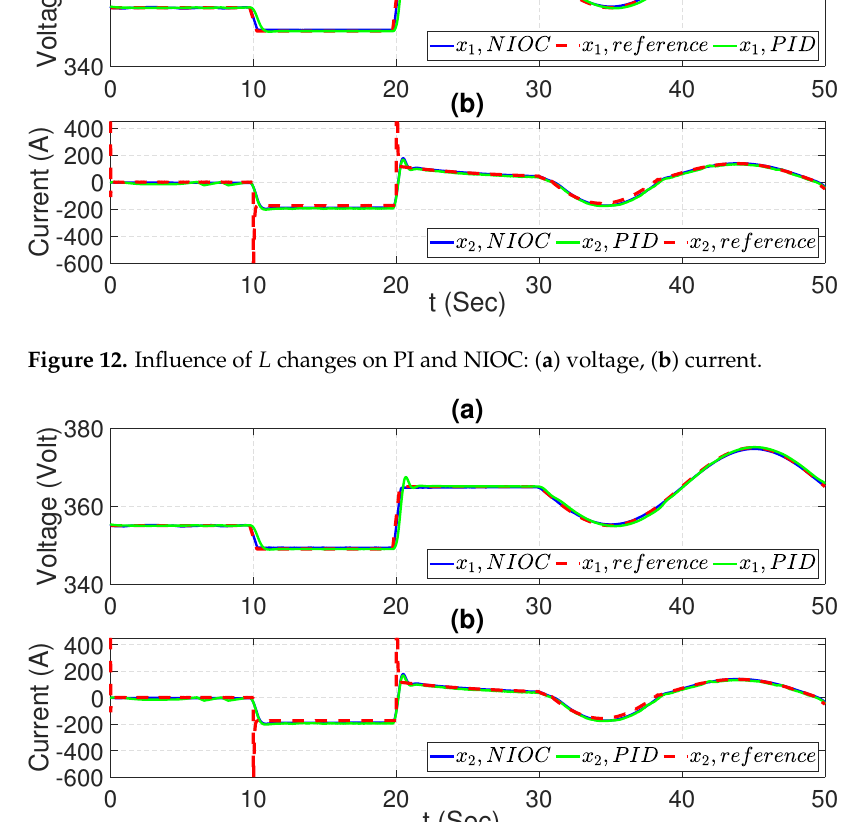
Figure 13. Influence of C changes on PI and NIOC: ( a ) voltage, ( b )